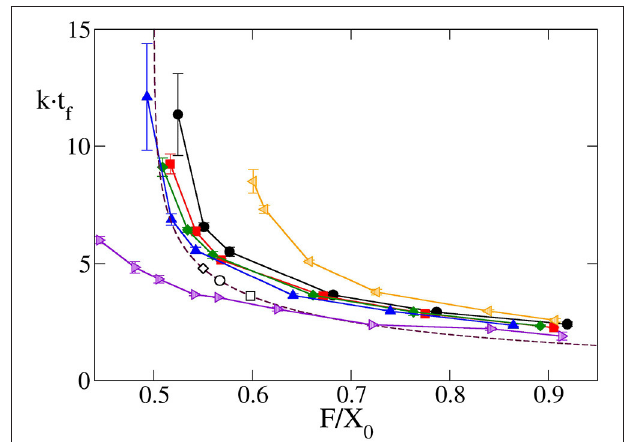
FIGURE 4 | Time required to complete eye growth multiplied by the constant growth rate ( k · t f ), as a function of ˜ F = F / X 0 obtained by computer simulation for the case of circular primordium and v gr = 2 σ/τ (black line and circles), 4 σ/τ (red line and squares), 6 σ/τ (green line and diamonds) and 10 σ/τ (blue line and triangles). Violet right triangles correspond to oblate primordium with X 0 / Y 0 = 0.540, orange left triangles correspond to prolate primordium with X 0 / Y 0 = 1.923. In these last two cases v gr = 6 σ/τ . Symbols are simulation results, and solid lines are guidance for the eyes. Additionally, the universal law Equation (17) is plotted as a maroon dashed line. The values of this final time for four Drosphila strains calculated using the parameters of Table 1 in Equation (17) are included as open circles for GMR > + , open squares for Or-R and open diamonds for GMR > Upd . Here, as well as in Figure 5 , it can be seen how the results of the simulation model with circular primordium agree with the predictions of the theoretical model, while there are systematic discrepancies for the cases of non-spherical primordium. Note that as ˜ F decreases the finalization time t f increase, and this increase is non-linear. is reached (top panel) and another where the eye grows without end (bottom panel). In these sequences it can be observed how the front of the P region (red particles) moves as if it were